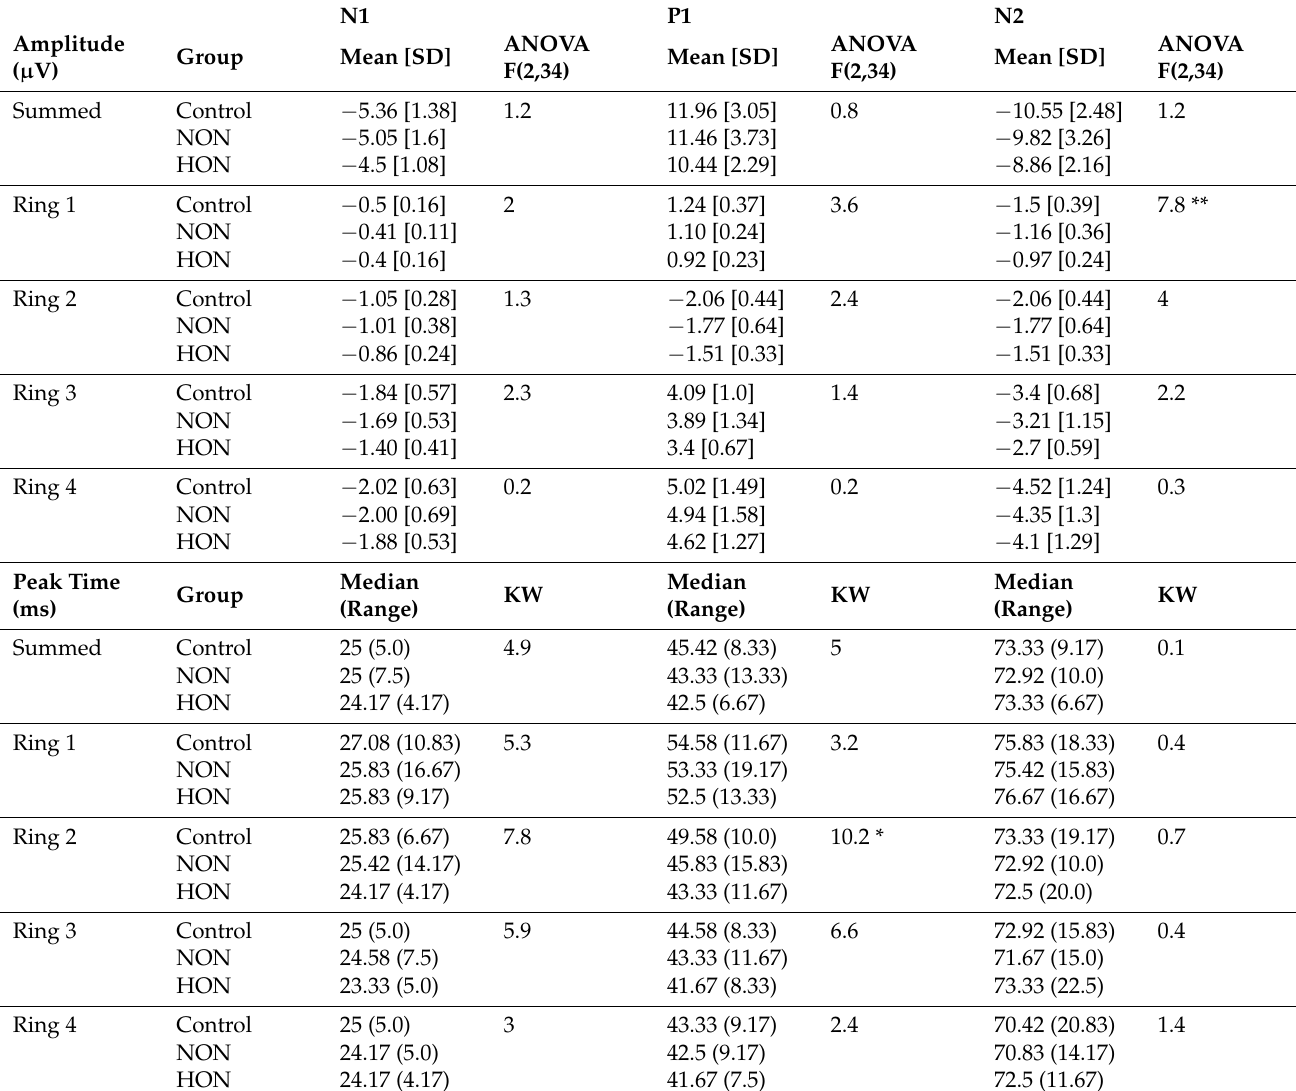
Table 2. Multifocal pattern electroretinogram ring analysis of amplitudes and peak